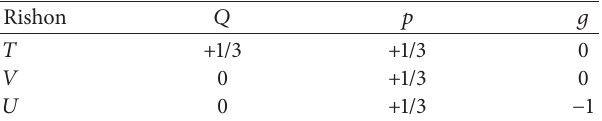
Table 4: CGM additive quantum numbers for rishons.